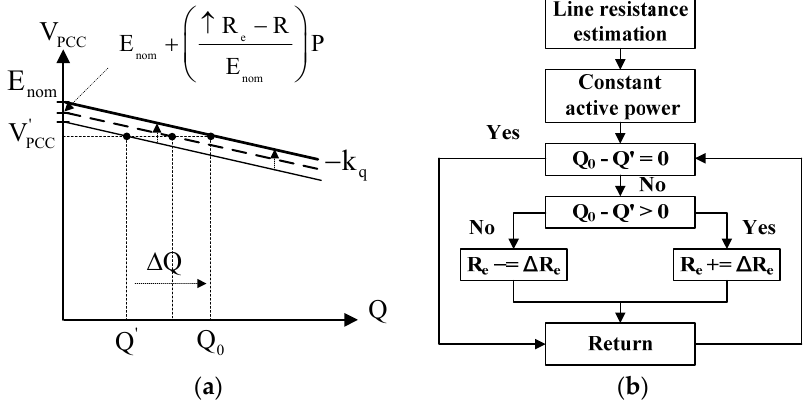
Figure 8. Algorithm for line resistance estimation: ( a ) Principle; ( b ) Estimation flow.